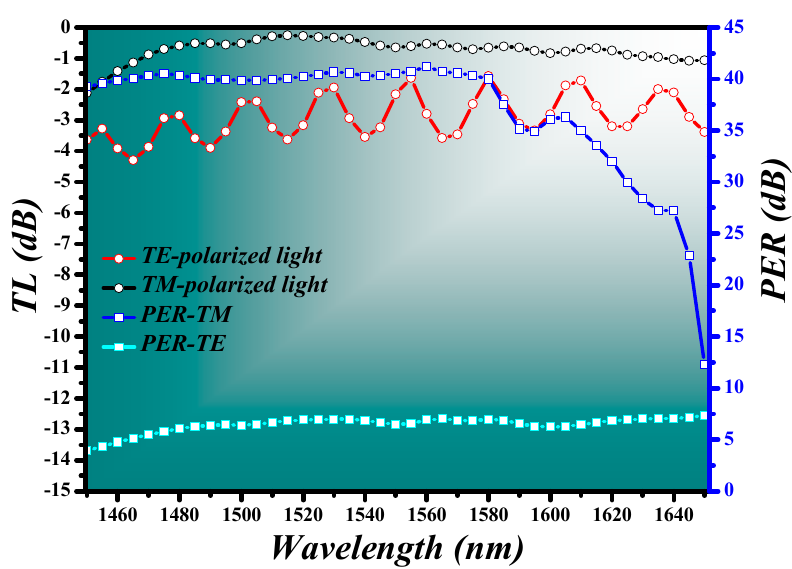
Figure 7. TL and PER of heterostructure PC.